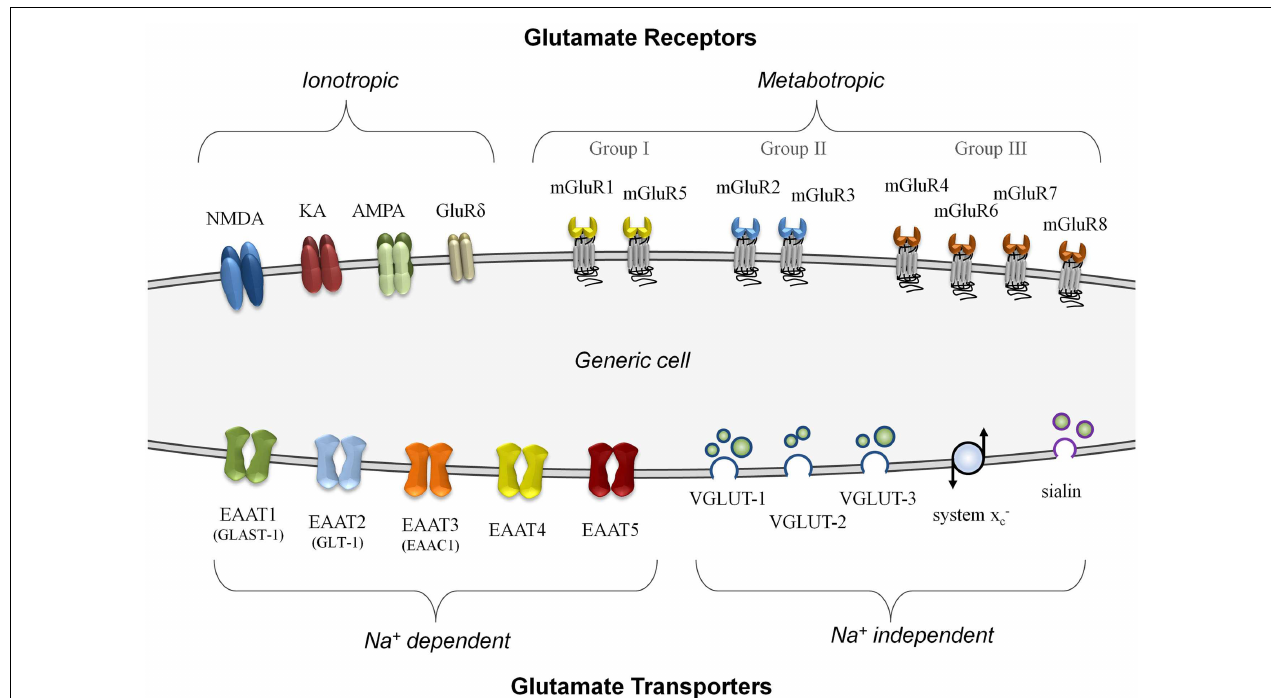
form ion channels although they can modulate other glutamate signaling components. Glutamate transporters are divided into those that are sodium-dependent and those that do not require a sodium gradient for their activity.The plasma membrane transporters (EAAT1 to EAAT5) can form ion channels and most often import glutamate.The sodium-independent transporters primarily export glutamate and these include the vesicular transporters (VGLUT-1 toVGLUT-3 and sialin) and the non-vesicular system x − glutamate/cystine